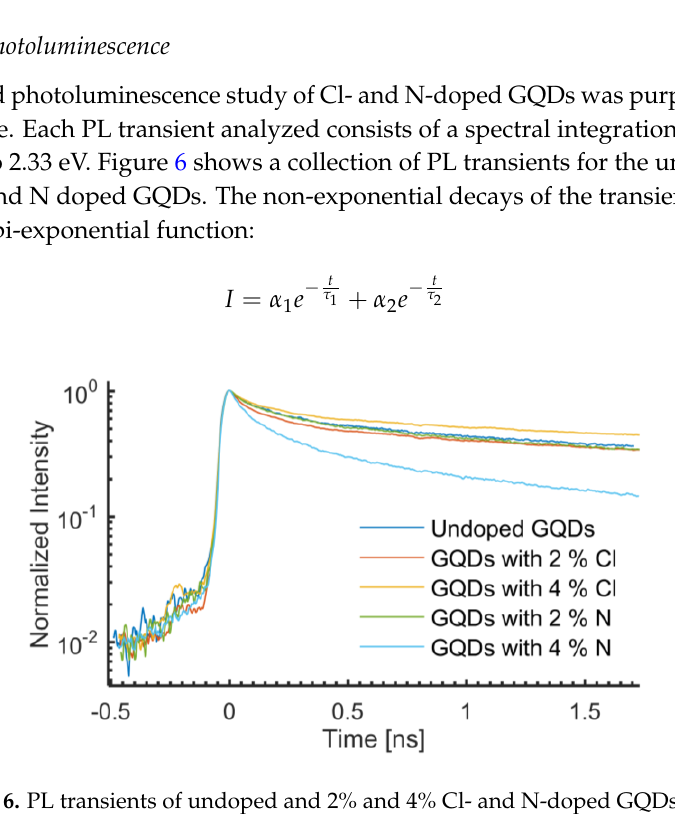
Figure 6. PL transients of undoped and 2% and 4% Cl- and N-doped GQDs on Si. Table 1. The short and long lifetime components of N- and Cl-doped GQDs samples. Samples